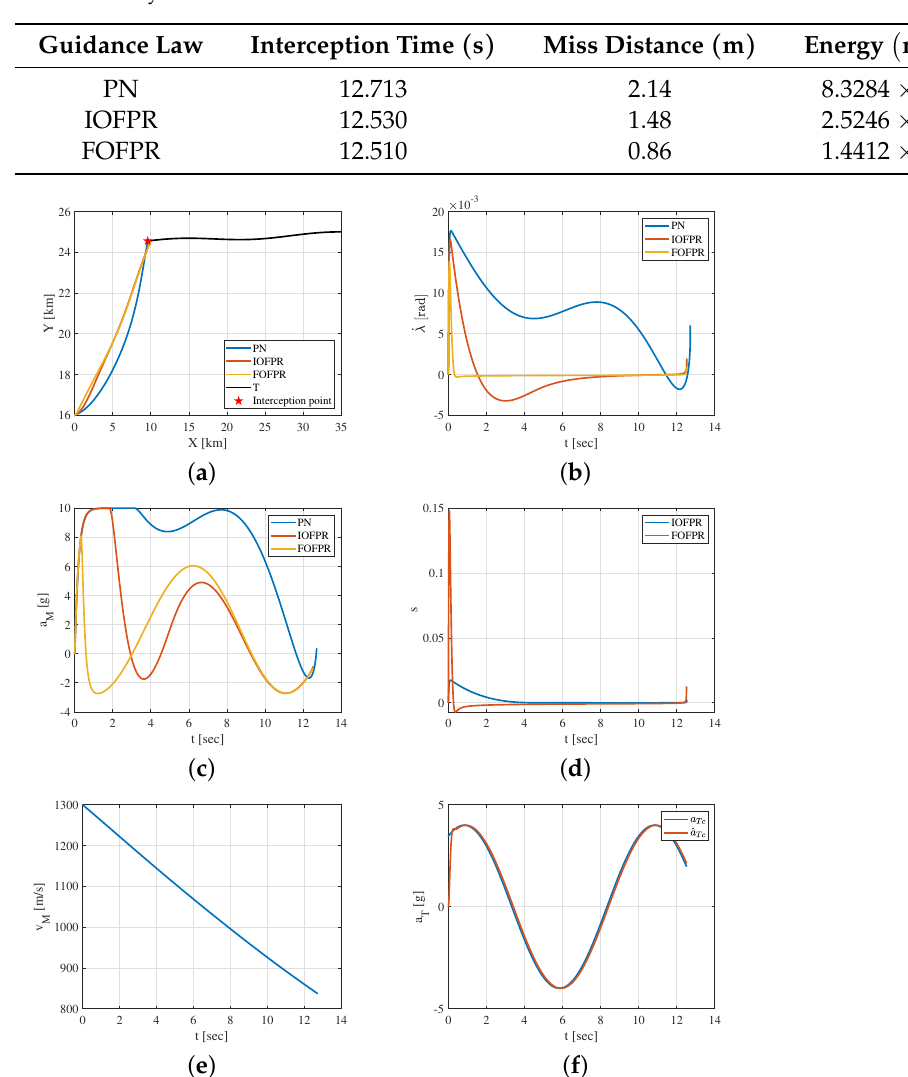
Figure 4. Interception results of the sinusoidal maneuver mode. ( a ) Trajectory; ( b ) LOS angular rate; ( c ) acceleration command; ( d ) sliding surface; ( e ) speed; ( f ) acceleration command of the hypersonic